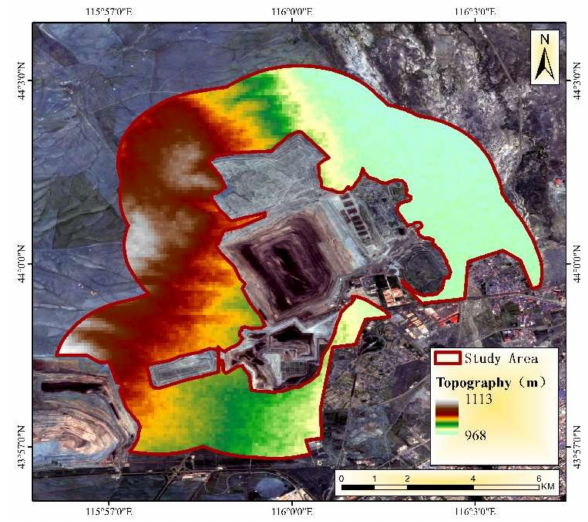
Figure 5. The spatial distribution of